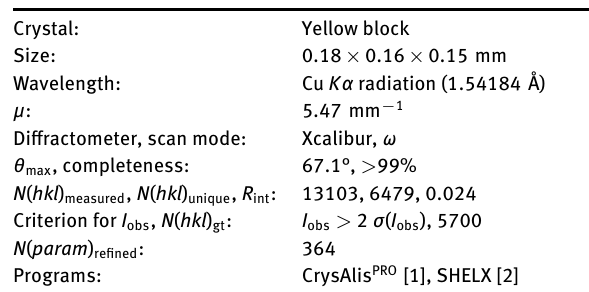
Table 1: Data collection and handling.